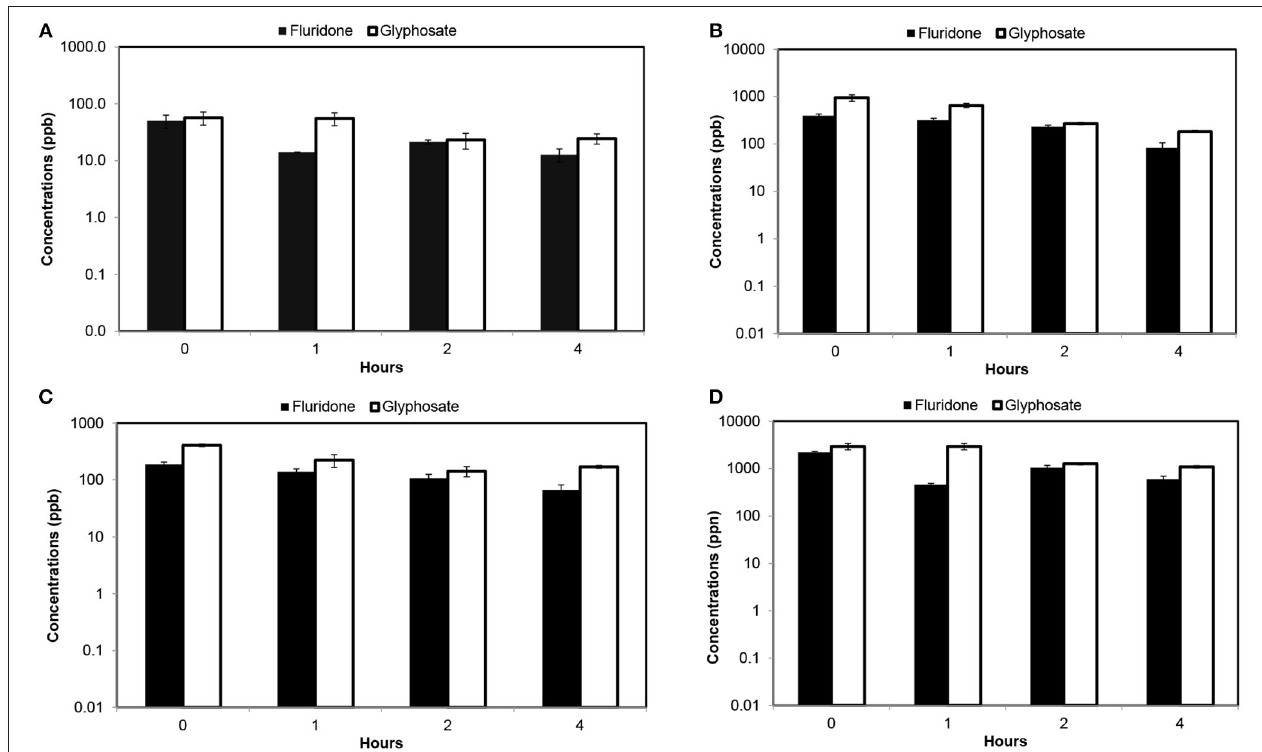
FIGURE 3 | Fluridone and Glyphosate concentrations determined in water after consecutive washes [error bars indicate standard deviation of 3 replicates]. (A) Determination of Fluridone and Glyphosate at initial concentrations of 100 ppb; (B) Determination of Fluridone and Glyphosate at initial concentrations of 1,000 ppb; (C) Determination of Fluridone and Glyphosate at initial concentrations of 500 ppb; and (D) Determination of Fluridone and Glyphosate at initial concentrations of 5,000